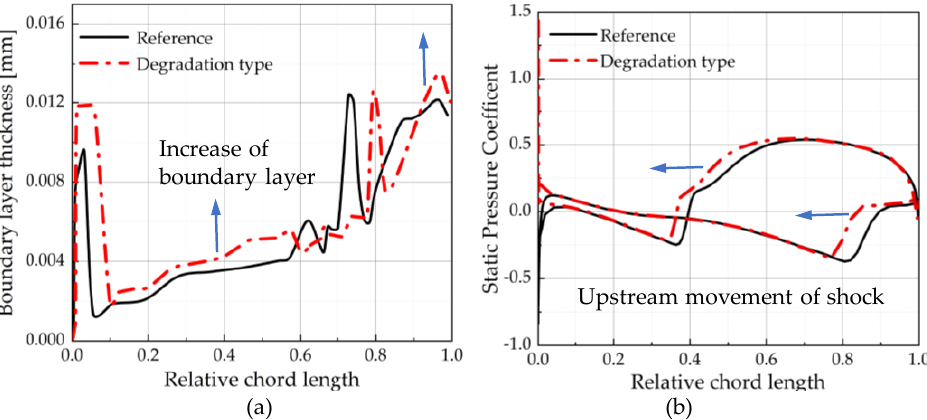
Figure 15. ( a ) Boundary layer thicknesses at the suction side and ( b ) static pressure coefficient of reference and degraded profiles.